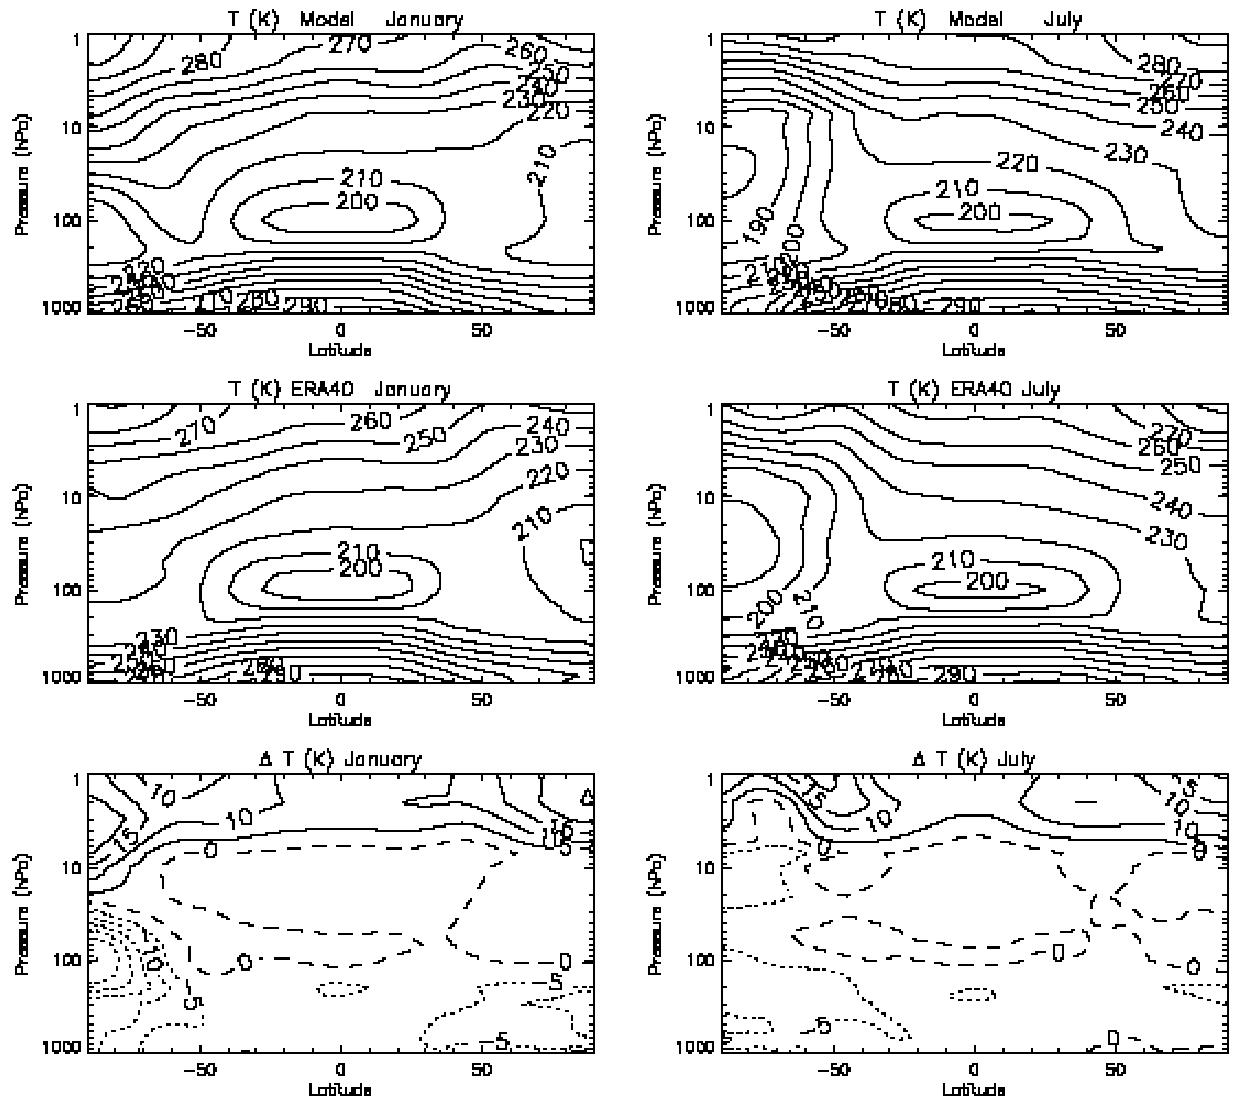
Fig. 1. January and July zonal mean distributions of the temperature for the period 1980–1999 from the LMDZ-REPROBUS model (top) Fig 1 : January and July zonal mean distributions of the temperature for the period 4 and the ERA 40 ECMWF reanalysis (middle) and their differences shown in steps of 5K. 1980-1999 from the LMDzRepro model (top) and the ERA 40 ECMWF reanalysis 5 reverses during solstice seasons, presenting a local maximum at the summertime polar (middle) and their differences shown in steps of 5 K. 6